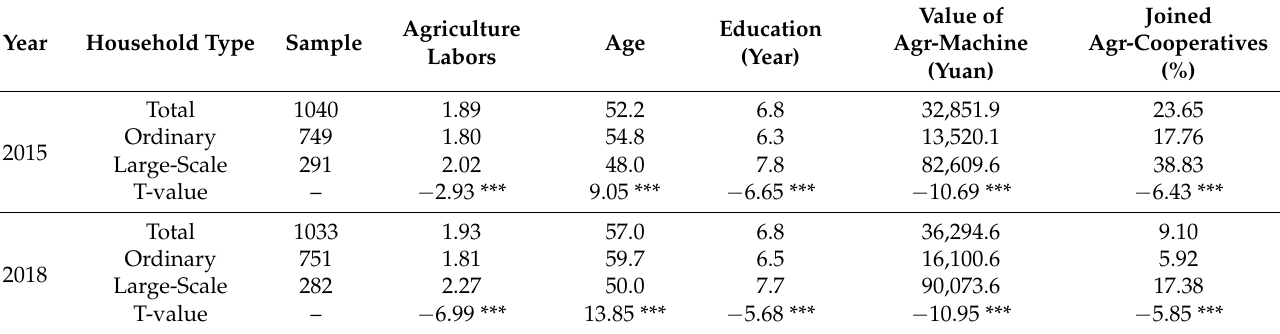
Table 7. T -test of the difference between household characteristics with a different